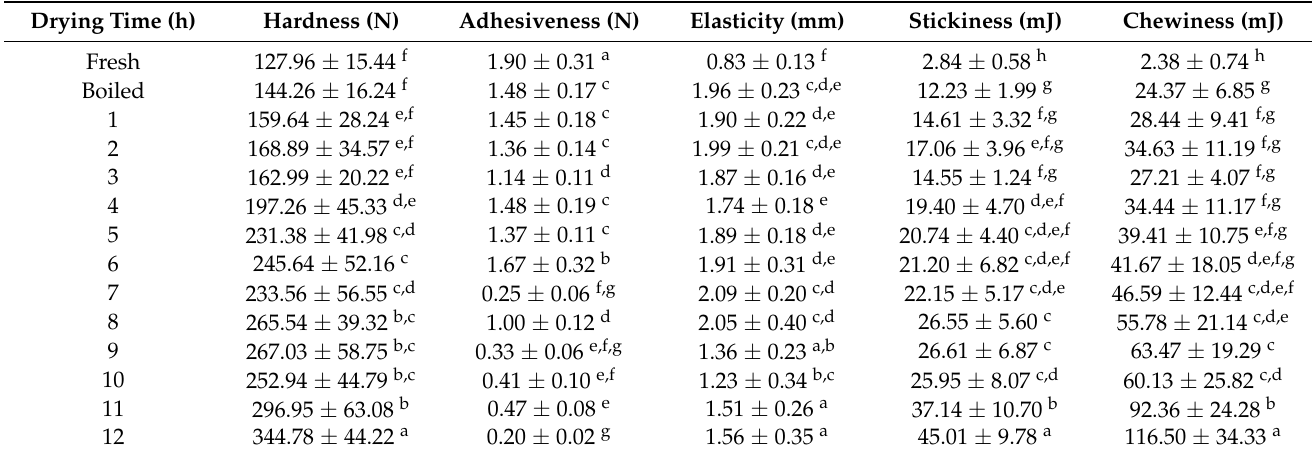
Table 1. Effects of hot air drying on the texture of